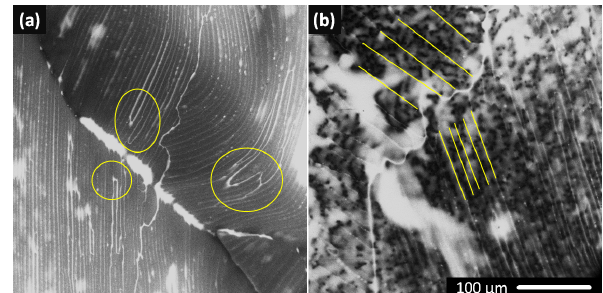
Figure 9. The interior of the fragmentized LN-frozen sample of 0.05MCsCl imaged with the ESEM at − 25 ◦ C. The gray areas rep- resent the ice, and the white regions indicate the CsCl brine. The brine was arranged in densely spaced parallel lamellae. Bridging of the ice was rare within a facet; examples of the effect are highlighted in (a) . The brine lamellae were equidistantly spaced within a facet. However, the distances between the lamellae might differ signifi- cantly among the facets (b) . Images of two additional samples for this freezing method are provided in Fig.